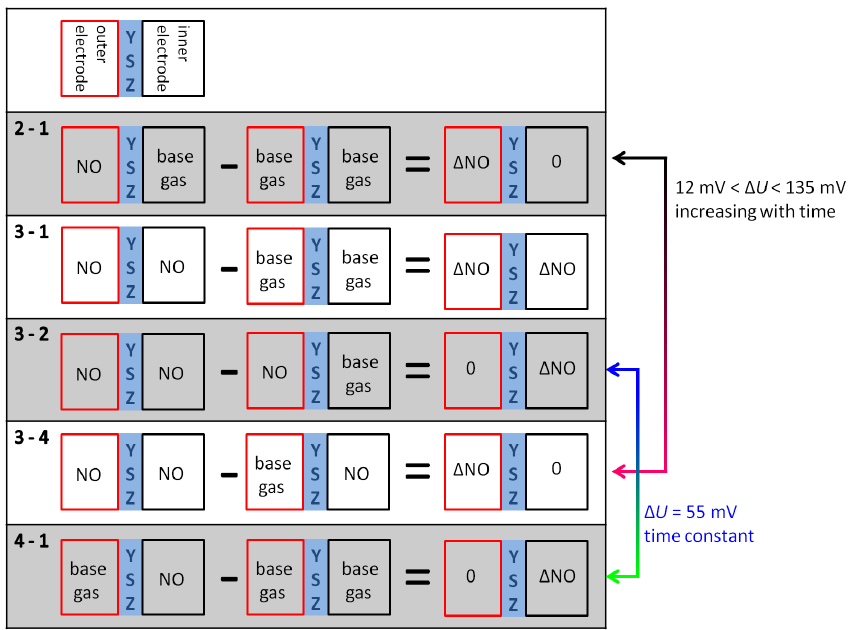
Figure 11. Illustration of the gas composition on both electrodes and the calculated differences according to Figure